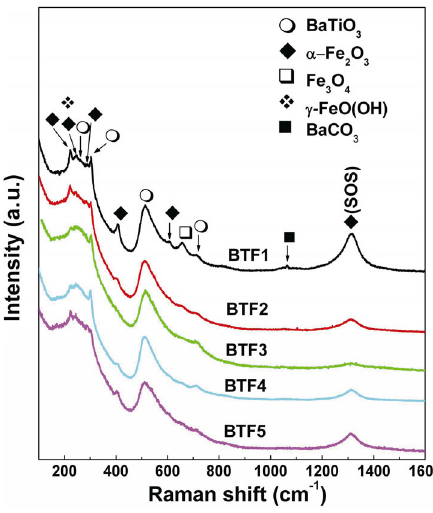
Fig. 2 Raman spectra of the BTF1–BTF5